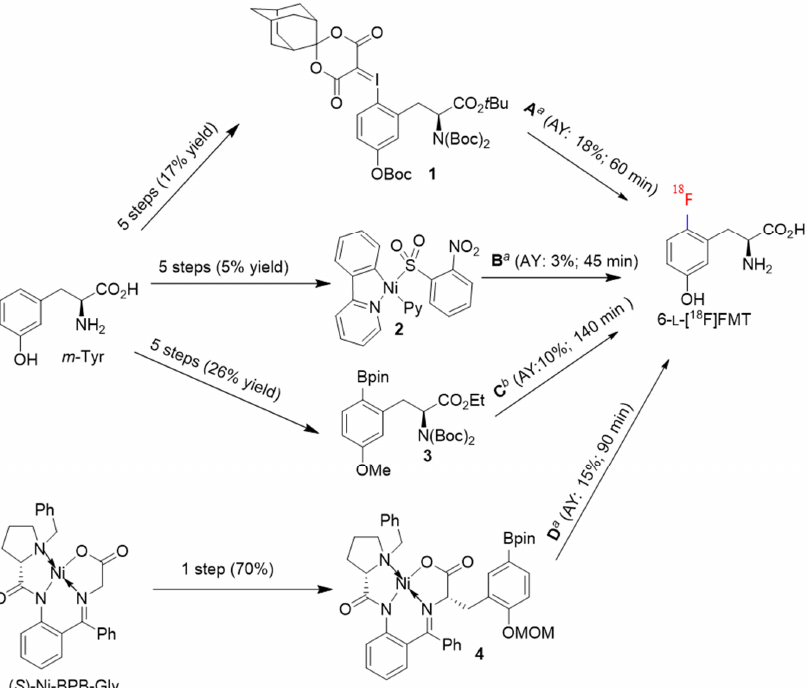
Figure 1. Preparation of 6- L -[ 18 F]FMT via late-stage radiofluorination with [ 18 F]fluoride. Radiolabeling conditions: ( A ) (i) azeotropic drying of [ 18 F]Et 4 NF/Et 4 NHCO 3 (×3), (ii) DMF, 120 °C, 20 min [24]; ( B ) [ 18 F]KF/K 2 CO 3 /18-crown-6, 1,1'-(phenyl- λ 3 -iodanediyl)bis(4-methoxypyridin-1-ium) trifluoromethanesulfonate, MeCN, r. t., 5 min [25]; ( C ) (i) azeotropic drying of [ 18 F]KF/K 2 C 2 O 4 /K2.2.2 (×5), (ii) Cu(py) 4 (OTf) 2 , DMF, 120 °C, 20 min, air [29]; ( D ) [ 18 F]Et 4 NF/Et 4 NHCO 3 , Cu(py) 4 (OTf) 2 , n BuOH/DMA, 110 °C, 15 min, air [34]. Procedures ( B ) and ( D ) avoid any azeotropic drying steps. a —manual synthesis; b — synthesis in a remotely controlled unit. AY—activity yield of the HPLC purified 6- L -[ 18 F]FMT [13]; r. t.—room temperature. Table 1. Automated production of 6- L -[ 18 F]FMT by Cu-mediated radiofluorination of ArylBPin precursors. Nr. Precursor